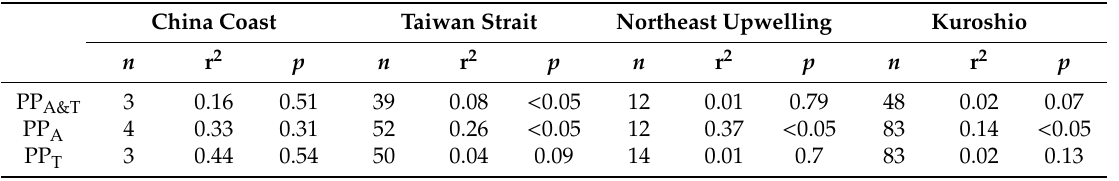
Table 3. Extracted number (n) of satellite-derived PPs with in situ PPs, correlation coe ffi cients (r 2 ), and p values for PP A&T , PP A , and PP T for whole years in four subareas. China Coast Taiwan Strait Northeast Upwelling